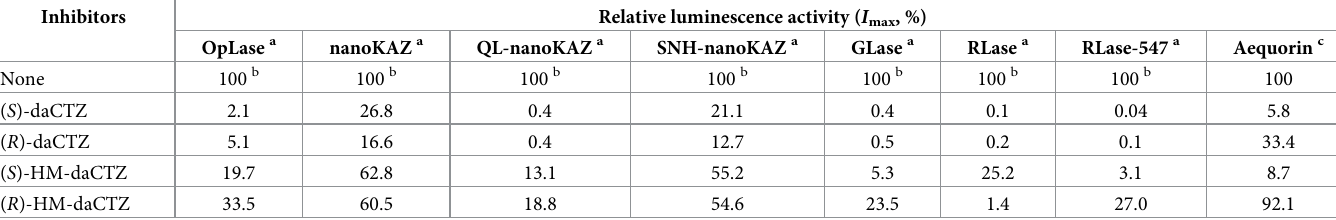
Table 8. Inhibition of luminescence activity of CTZ-utilizing luciferases with deaza-coelenterazine (daCTZ) analogs as inhibitors.